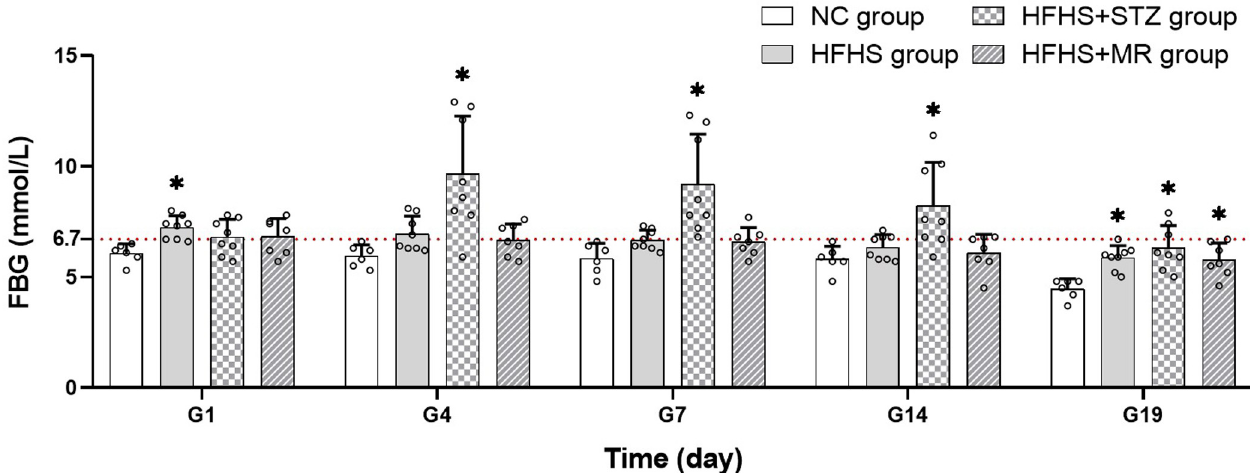
Fig 1. FBG of the four rat groups. G: gestational days (day). � P < 0.05 vs. the NC group.